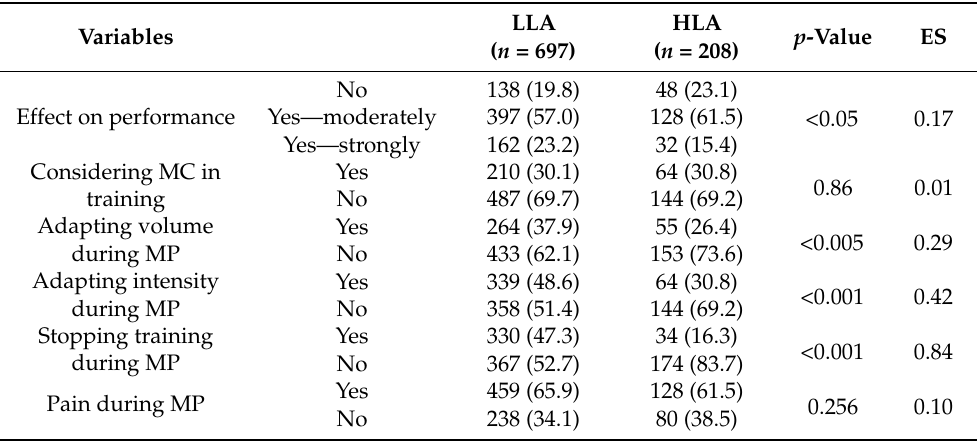
Table 3. Influence of the menstrual cycle (MC) on training habits, related to different athletic levels without contraceptive hormones ( n = 905).